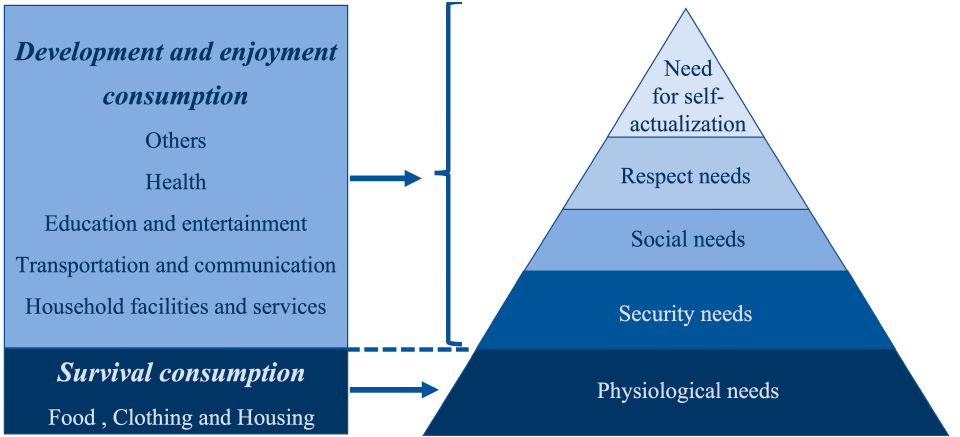
Figure 6. Consumption category and Maslow’s hierarchy of needs.